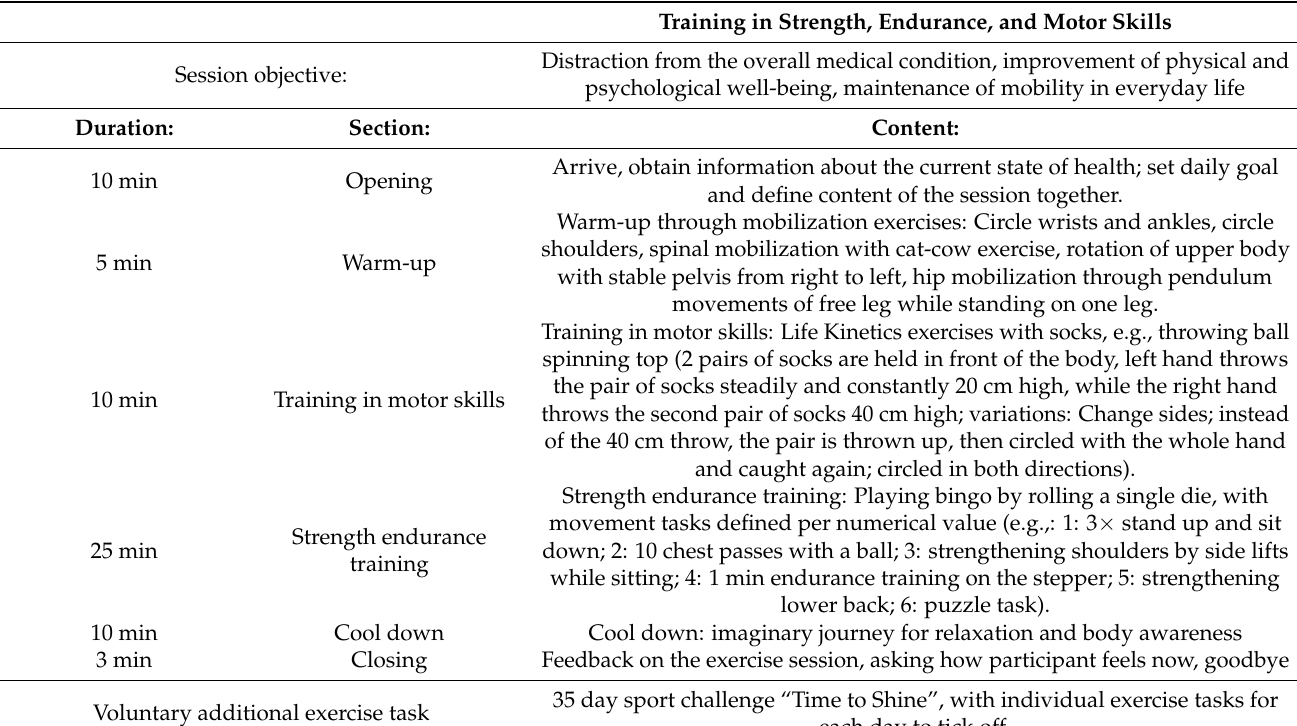
Table 1. Example of an exercise session during a home visit with the 13-year-old female. Training in Strength, Endurance, and Motor